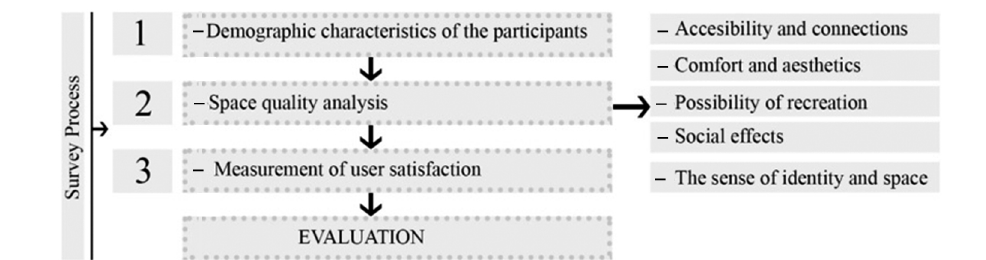
Figure 5. Conceptual framework of the